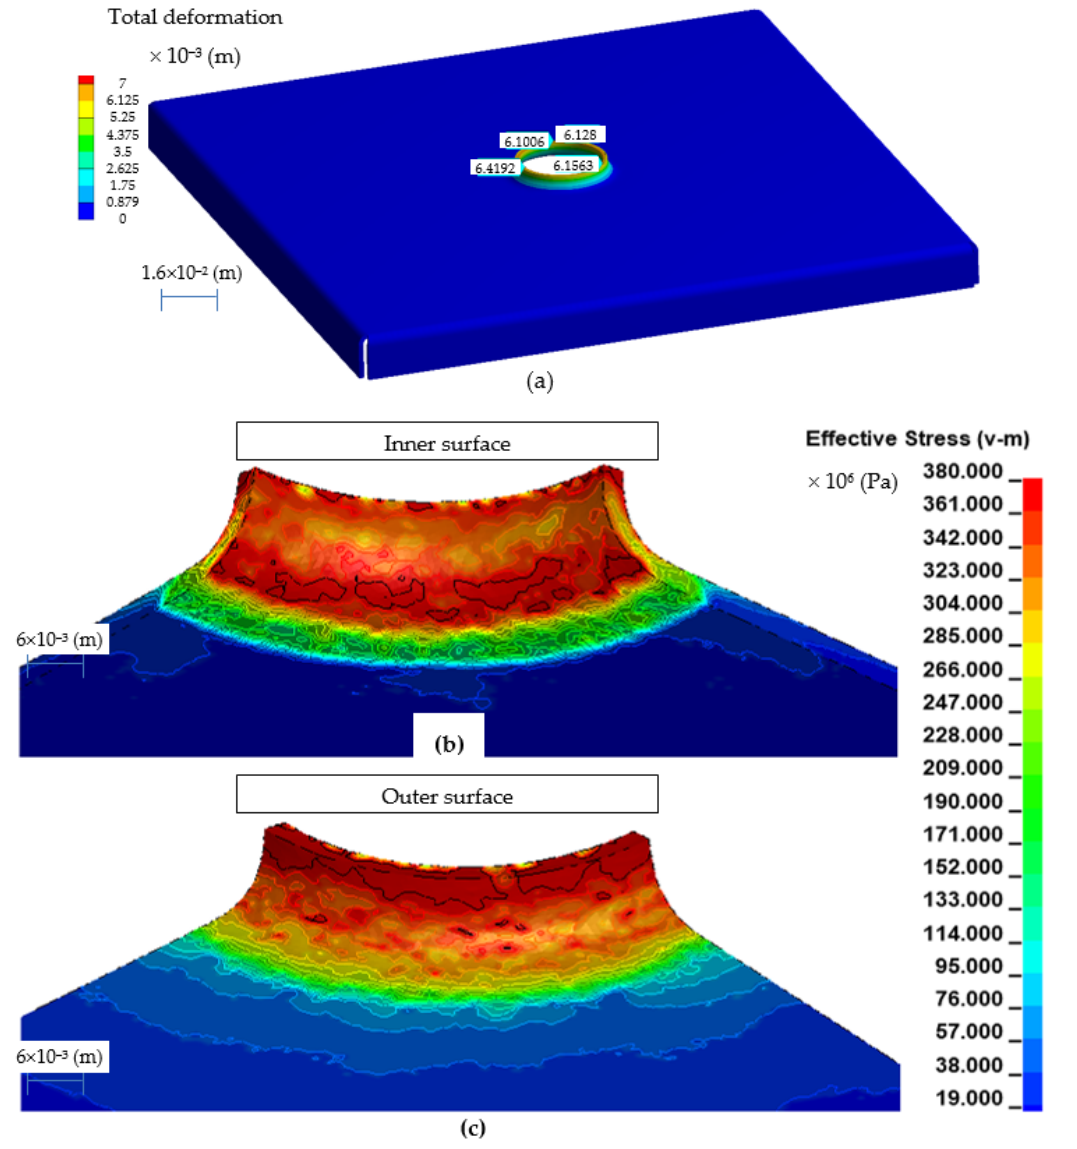
Figure 9. Effective stress in the embossed flange with a punch for the h6 model: view of the entire model ( a ), view of the inside side ( b ), and view of the outside side ( c ).